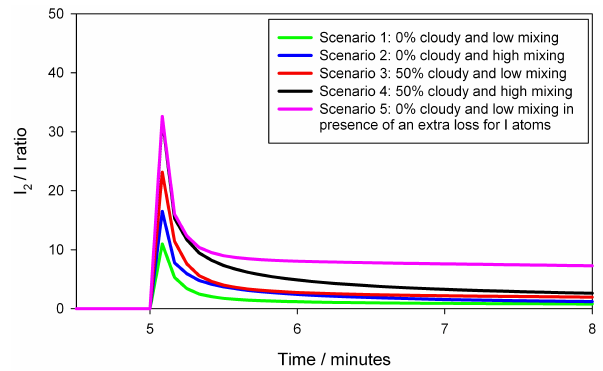
Fig. 4. I 2 /I ratio change for five scenarios: (1) photolysis is cal- culated with 0% cloud cover and slow vertical mixing close to the surface is considered, (2) 0% cloud cover with faster mixing close to the surface, (3) 50% cloud cover with slow mixing close to the surface, (4) 50% cloud cover, with fast mixing close to the surface and (5) 0% cloud cover with slow mixing close to the surface in the presence of an extra loss for I atoms through reaction with an unknown